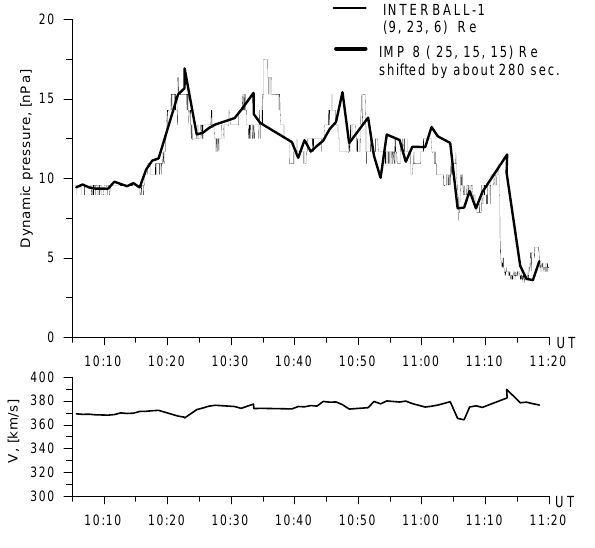
Fig. 2. Distributions of absolute pressure